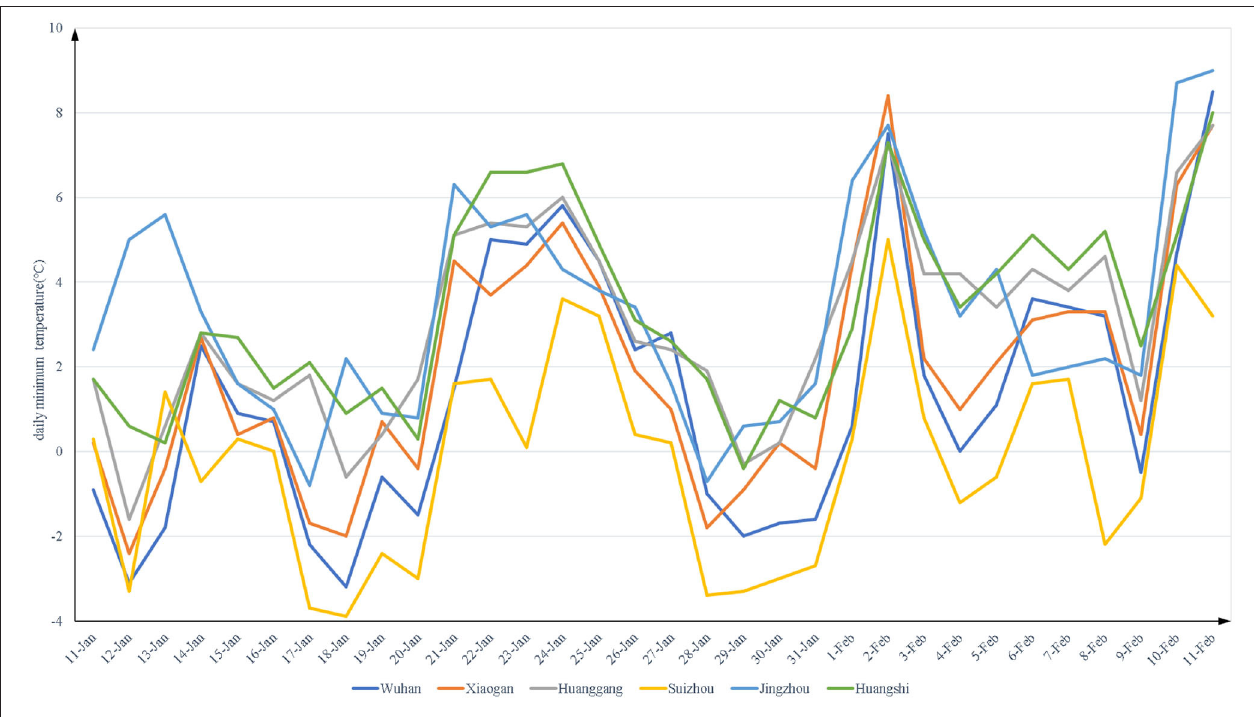
FIGURE 3 | The daily minimum temperature ( ◦ C) from 2020-1-11 to 2020-2-11 in